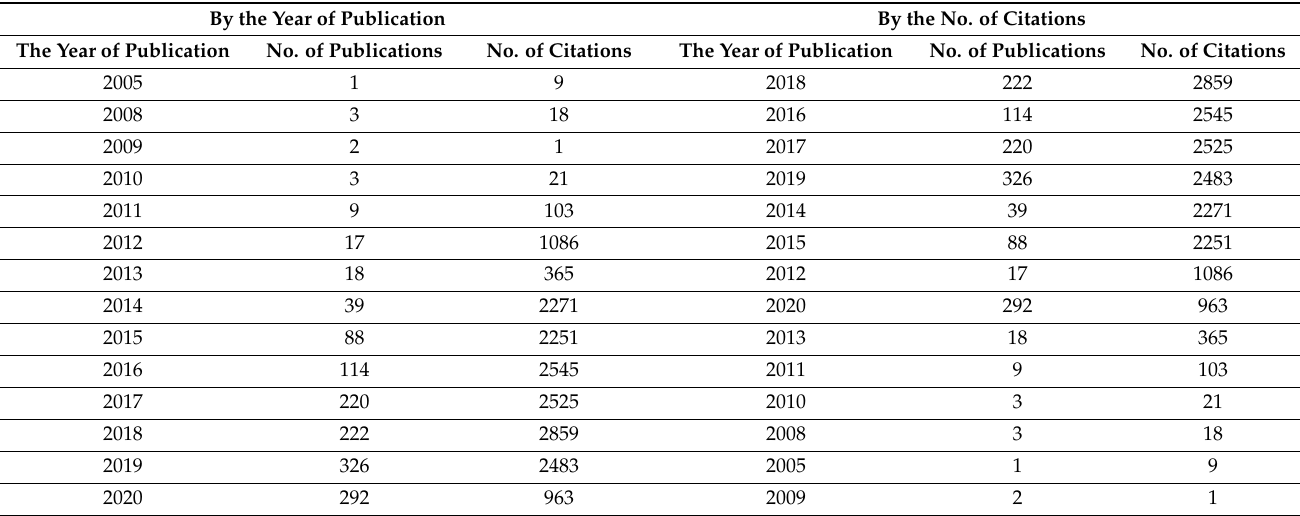
Table 3. Articles with the highest number of citations by the year of publication.